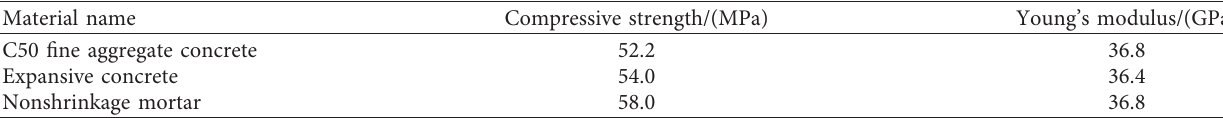
Figure 4: Construction sequence of the bridge model and prototype bridge. Table 2: Material properties of concrete.